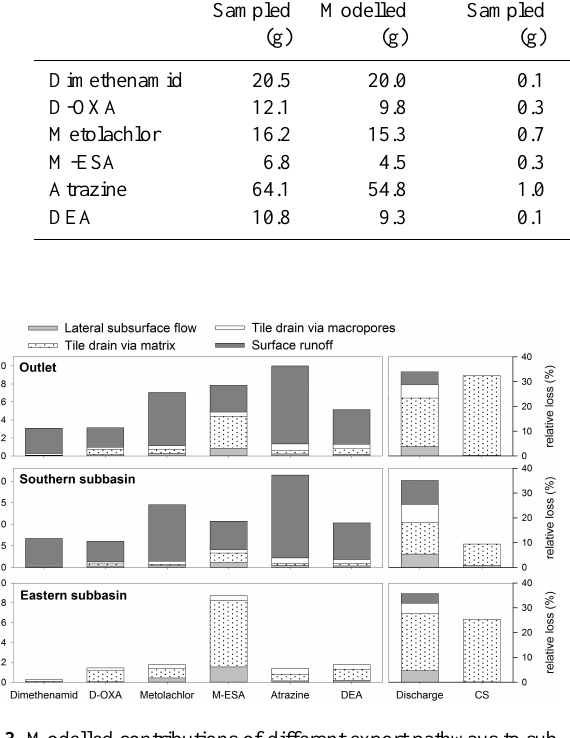
Fig. 3. Modelled contributions of different export pathways to sub- stance export for the whole modelling period at all three stations. The fractions are related to the corresponding sum of applied pesti- cide mass and initial